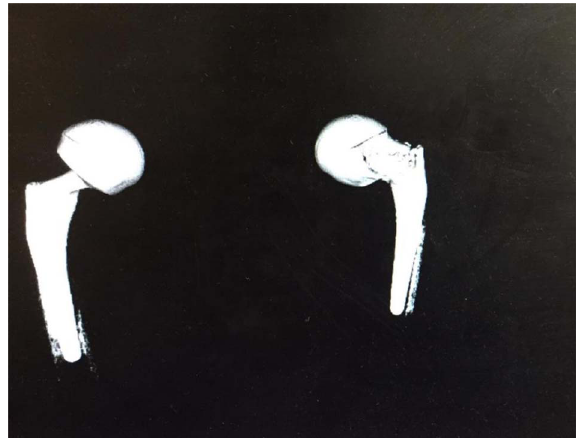
Figure 2. CT scan (3D Construction), showing the dislocation.